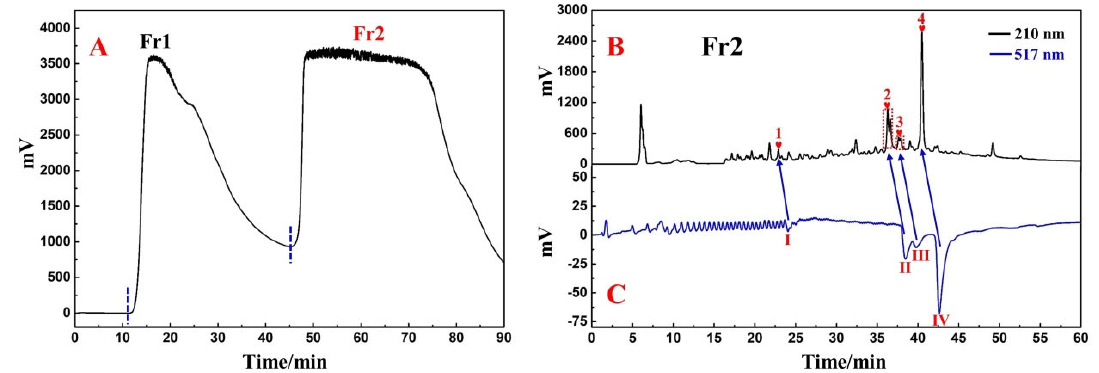
Figure 1. Chromatogram of D. heterophyllum extract separation ( A ) with a silica gel medium-pressure liquid chromatography system. The analytical chromatogram of the Fr2 fraction, acquired at a wavelength of 210 nm, from D. heterophyllum ( B ), after separation on a ReproSil-Pur C18 AQ analytical column. The HPLC was performed at a flow rate of 1.0 mL/min, using a column temperature of 30 °C, with 0.01% v / v trifluoroacetic acid in water and acetonitrile (ACN) as mobile phases A and B, respectively, and with a gradient of 0–60 min using 0–100% B. Scavenging profile of 1,1-diphenyl-2-picrylhydrazyl (DPPH) radicals ( C ), acquired at 517 nm while using a flow rate of 0.8 mL/min for the DPPH solution. The negative peaks I ‐ IV correspond to active peaks 1 ‐ 4, respectively.